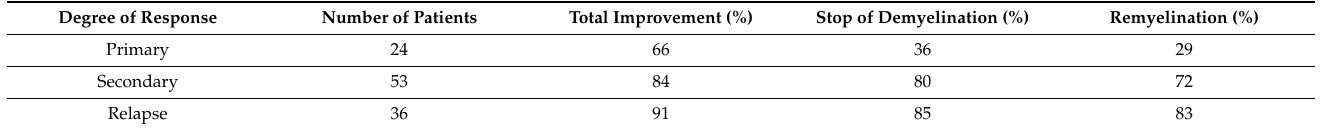
Table 1. Bee venom therapy experiment on patients with multiple sclerosis in Chelyabinsk Russian center [91]. Degree of